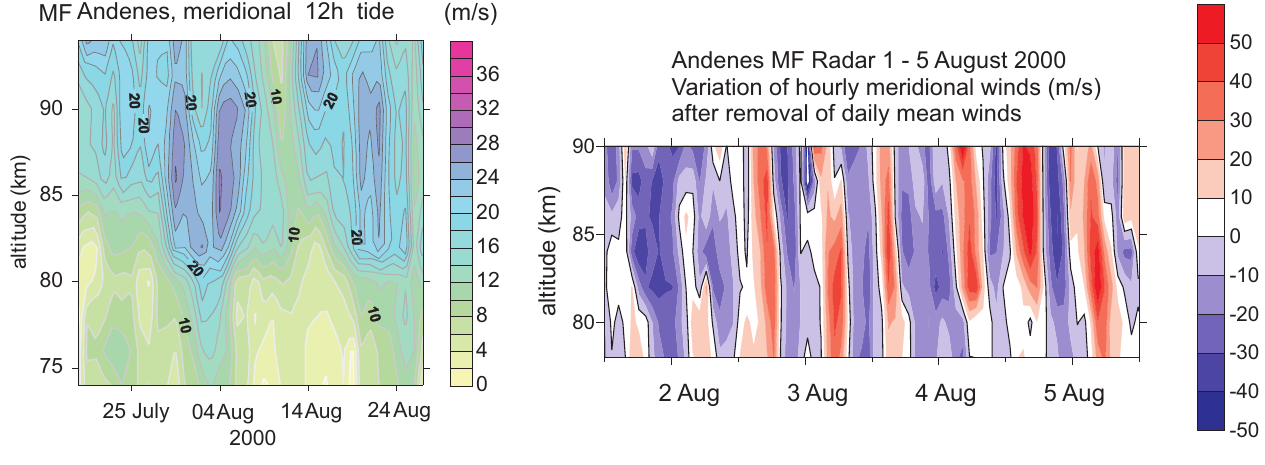
Fig. 5. Model results: (a) Temperature variations under the influence of a semidiurnal tidal wave; (b) resulting PMSE strengths (coloured) and lidar back scatter ratio at 532nm (black lines).